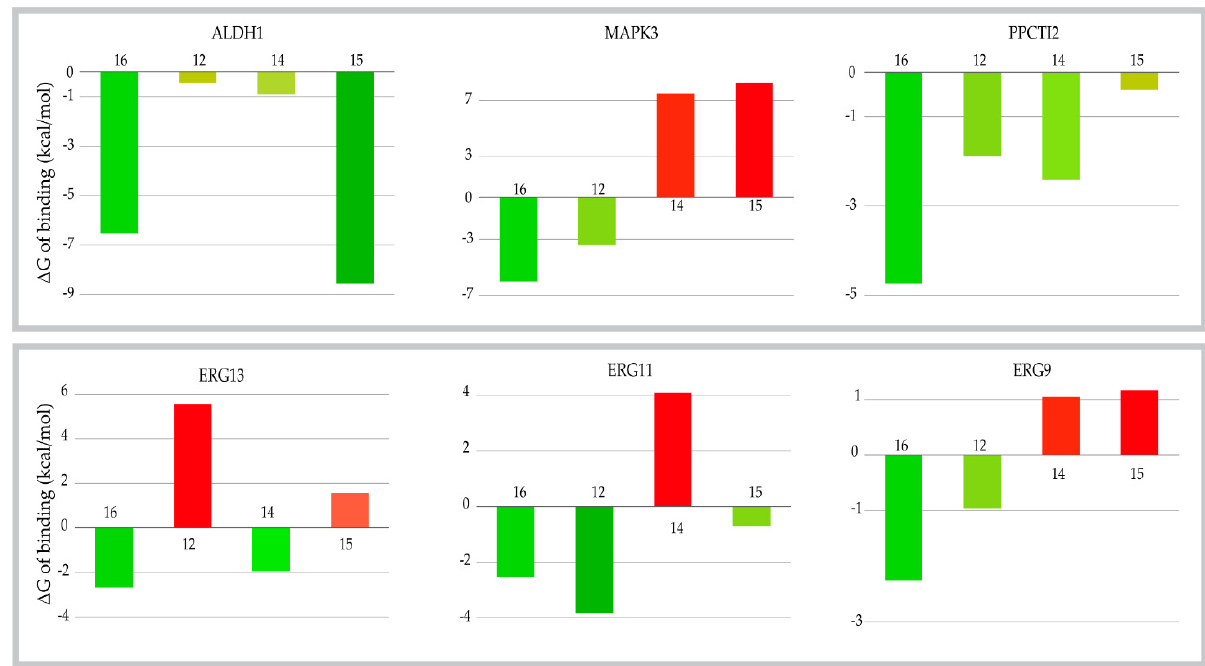
Figure 4. Predicted free energies of binding of compounds 12 , 14 and 15 to ALDH1, MAPK3, PPCTI2, ERG13, ERG11 and